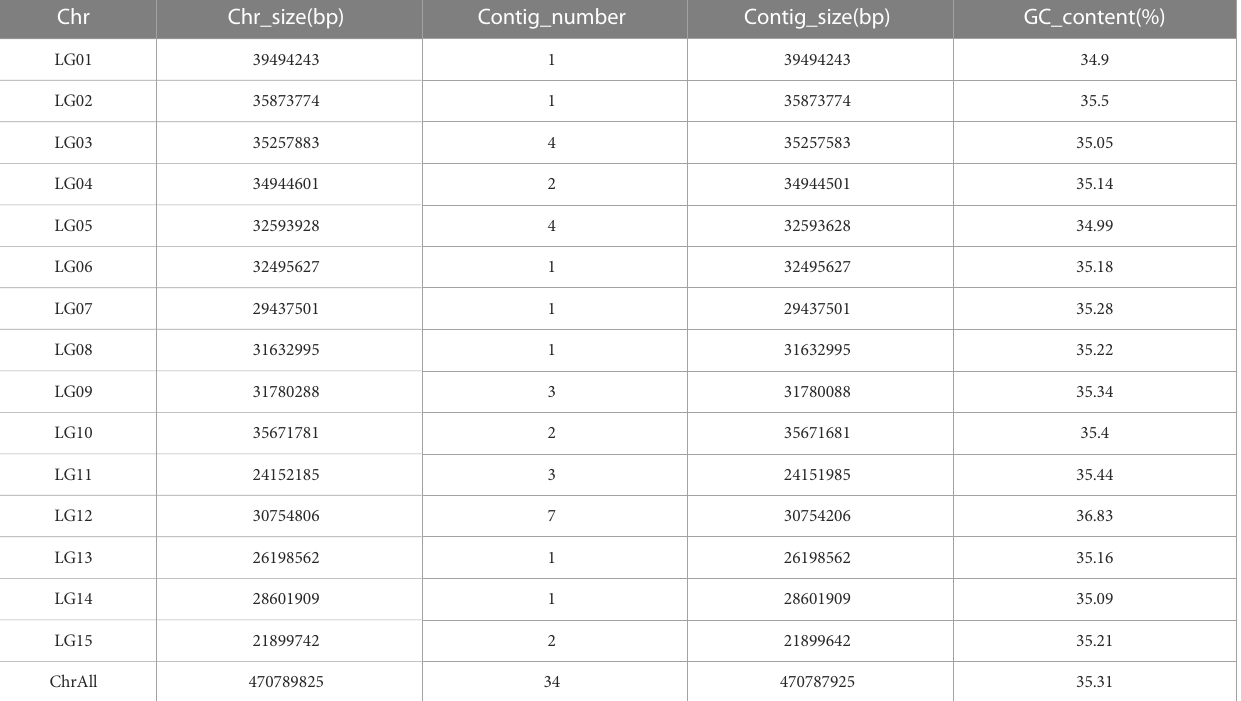
TABLE 1 Genome Statistic of Xanthoceras sorbifolia superior